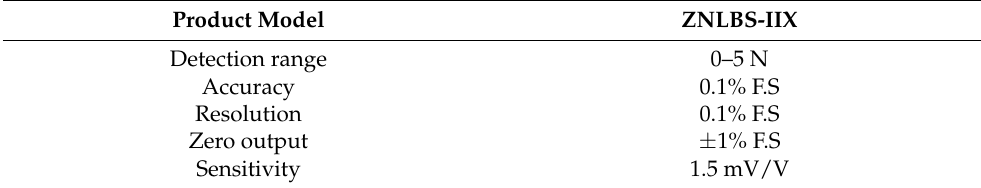
Figure 2. The slave side of the robot system. Table 1. Specific parameters of the force